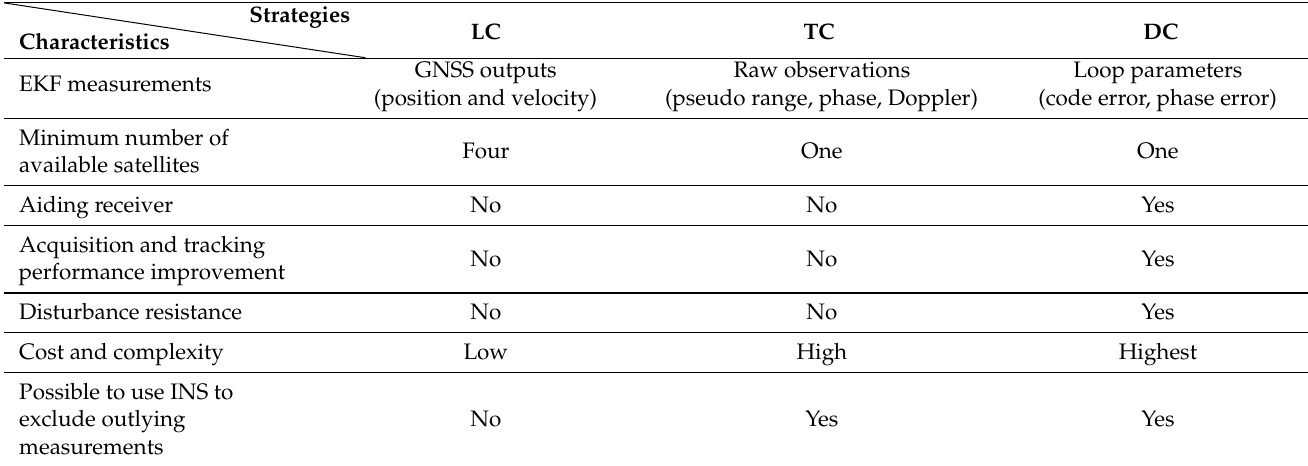
Table 1. The characteristics of three integration